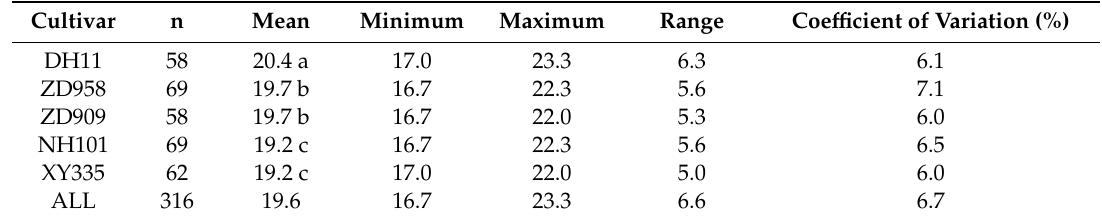
Table 2. Final leaf numbers of di ff erent maize cultivars across all locations during 2013–2016. Cultivar